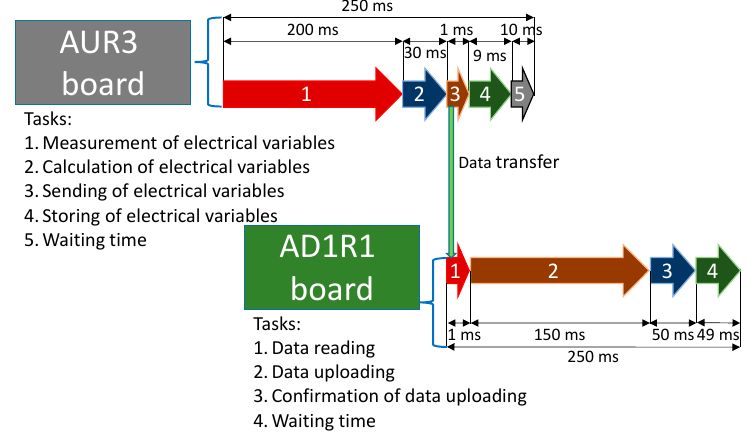
Figure 4. Process timeline for the OSPPSM.